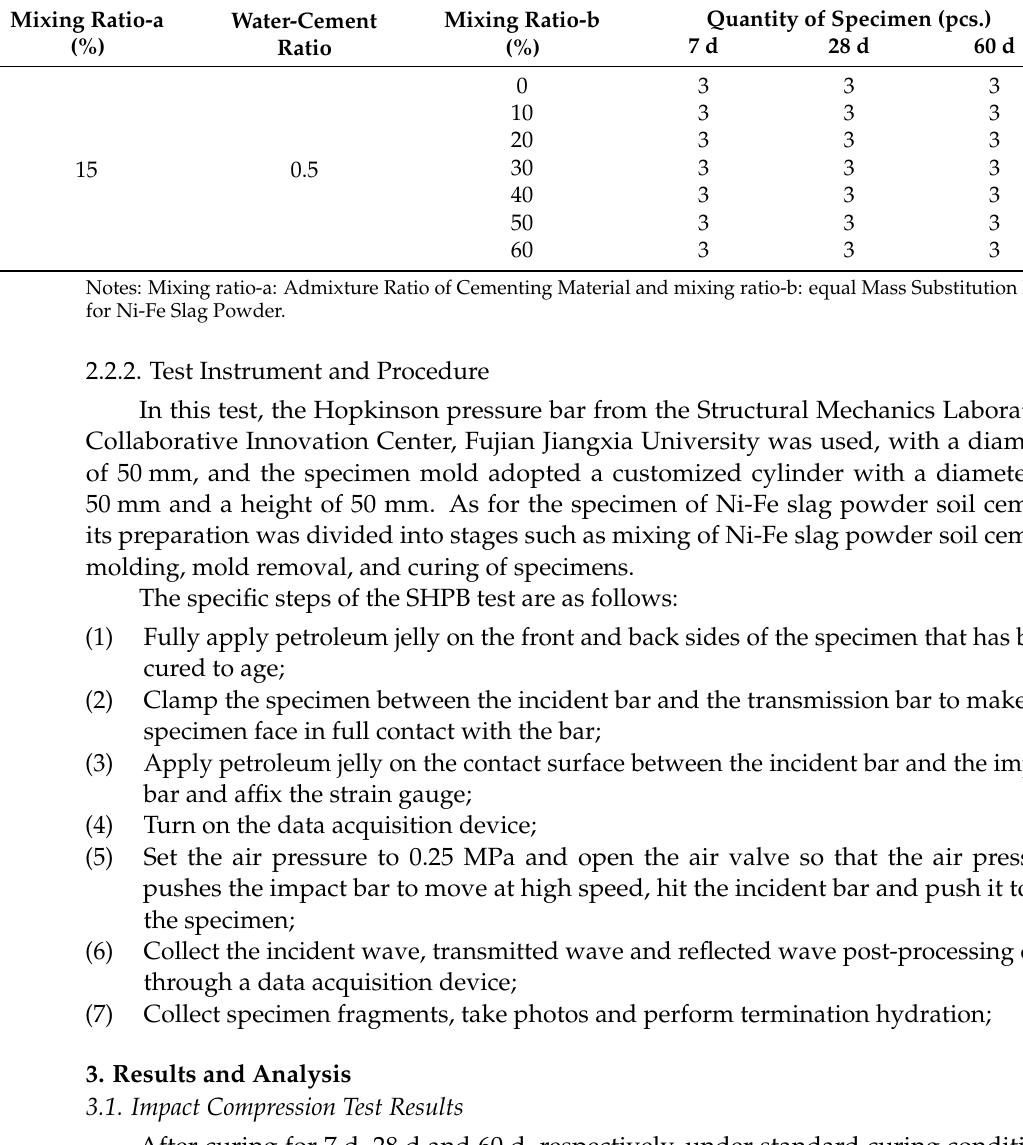
Table 3. SHPB Test